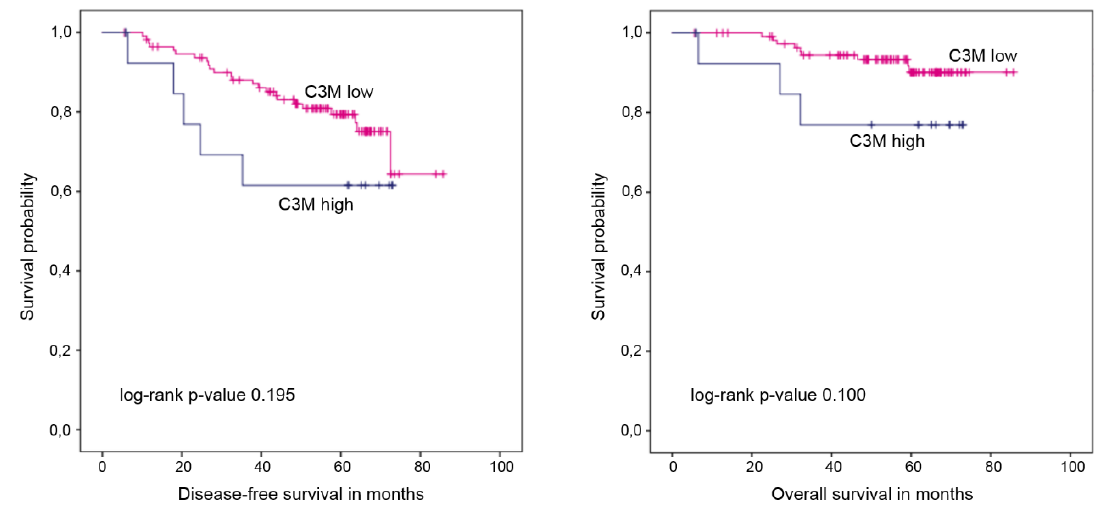
Figure 3. Kaplan–Meier plots of disease-free and overall survival stratified by C3M levels at baseline.